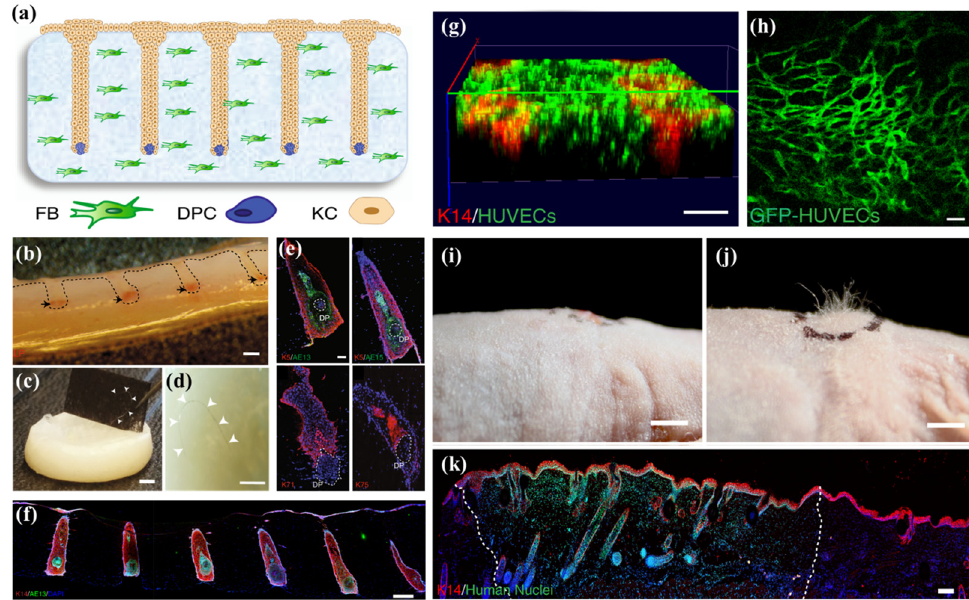
Figure 5. Hair follicle-developed skin constructs by the over-expression of Lef-1. ( a ) Schematic diagram on the fabrication of skin constructs using 3D printed micro papilla mold. ( b ) Cross section of the skin constructs exhibiting ALP (black arrows). ( c , d ) Prolonged in vitro culture led to hair fiber formation and protrusion. ( e ) IF staining on the HFU shows the expression of HFU-specific markers. ( f ) Expression of AE13 in HFU, comprised with Lef-1-transfected HFDPCs, showing highly efficient hair differentiation. ( g ) Capillary-like networks after 3 days of culture. ( h ) Explanted pre-vascularized skins, indicating host vascularization and blood supply to the grafts. ( j ) The human hair growth on the nude mouse skin after 4–6 weeks of transplantation, and ( i ) control. ( k ) The human nuclear staining on the explanted grafts. The boundaries (dashed line) between mouse and human tissues are revealed. The sizes of scale bars are as follows: ( b – d , g , i , j ) 2 mm, ( e , h ) 100 μ m, ( f ) 300 μ m, and ( k ) 200 μ m. The data were reproduced from Ref [79]. Copyrights 2018 Nature Publishing Group.